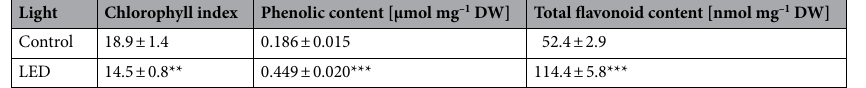
Table 3. Chlorophyll index, the average content of total phenolics a [µmol mg –1 DW] and total flavonoids b [nmol mg –1 DW] in leaves of common buckwheat cv. ’Panda’ under different controlled-environment production systems. Control—solar light supplemented with HPS (High-Pressure Sodium) lamps; LED (Light- Emitting Diodes). Values represent means ( n = 20 for chlorophyll index; n = 3 for phenolic and total flavonoid content) ± SE. Stars indicate significant difference between means; ** p < 0.01, *** p < 0.001 (Student’s t test). a µmol gallic acid equivalent (GAE)/mg –1 DW. b µmol quercetin equivalent (QUE)/mg –1 DW.